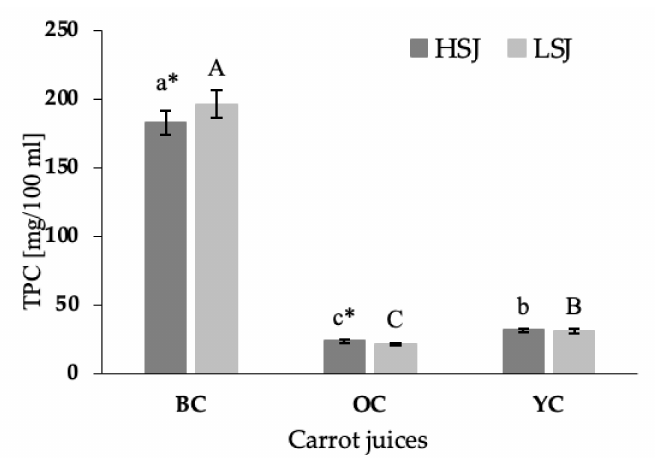
Figure 2. Results of total phenolic content (TPC) in black, orange and yellow carrot juices. Abbreviations: BC—black carrot, OC—orange carrot, YC—yellow carrot, HSJ—high-speed juicer, LSJ—low-speed juicer. Each bar corresponds to the mean of three independent replicates with error bars indicating the standard deviations. Di ff erent letters (abc / ABC) indicate significant di ff erences among samples ( p < 0.05). Statistically significant di ff erences ( p < 0.05) between method of extraction each carrot variety are marked by *.